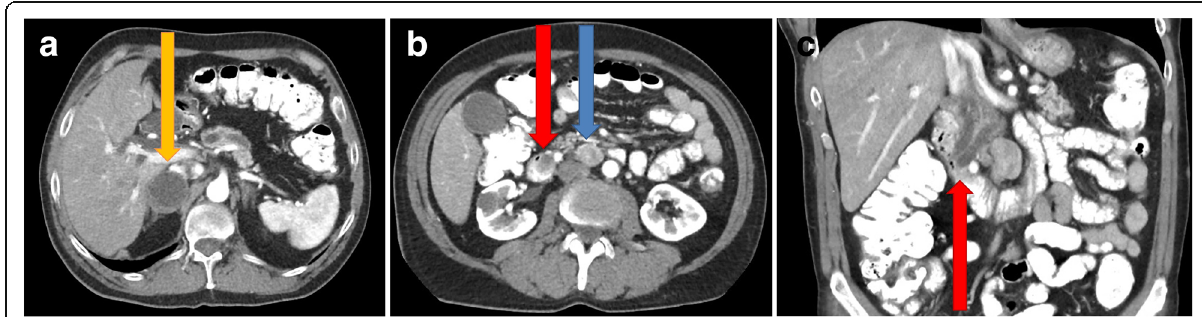
Fig. 1 a Abdominal CT (transversal scan) - expansion of the right adrenal gland 4 × 4 cm in size (orange arrow). b Abdominal CT (transversal scan) - tumor of the ampulla of Vater (red arrow) with associated lymphadenopathy (blue arrow). c Abdominal CT (coronal scan) - tumor of the ampulla of Vater (red arrow) with a double-duct sign